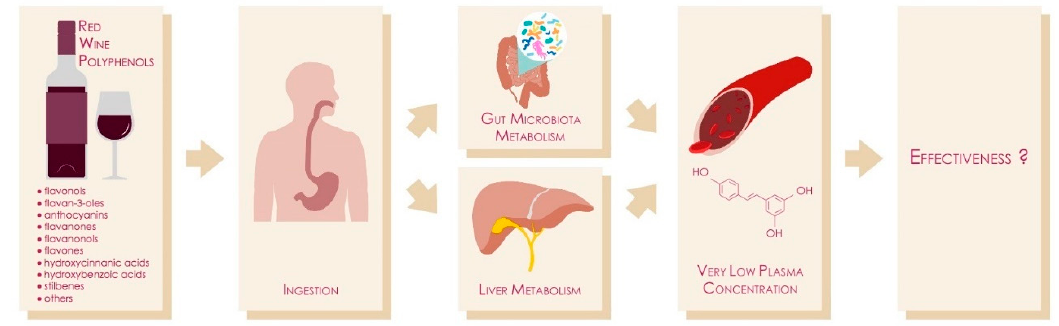
Figure 1. Schematic overview of current pitfalls in wine (poly)phenols research.